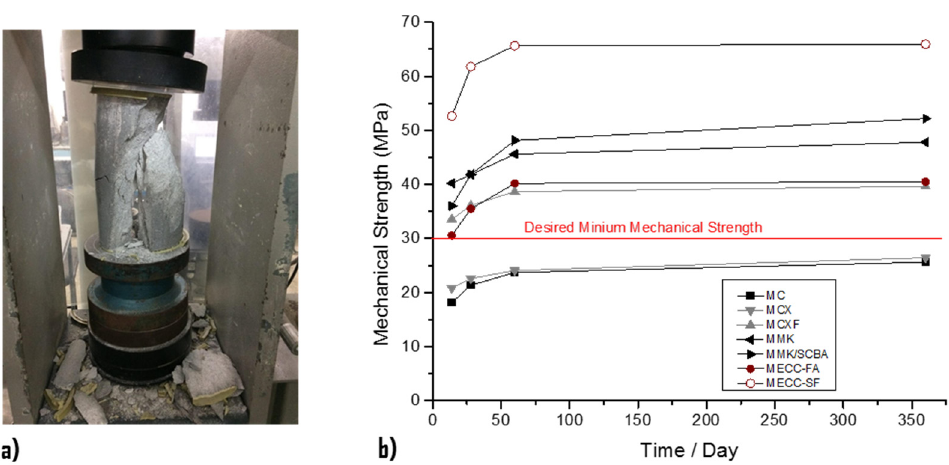
Figure 2. Compressive strength of mortars. ( a ) Test according to ASTM C39 [42]. ( b ) Measuring at ages 7, 14, 60, and 360 days.